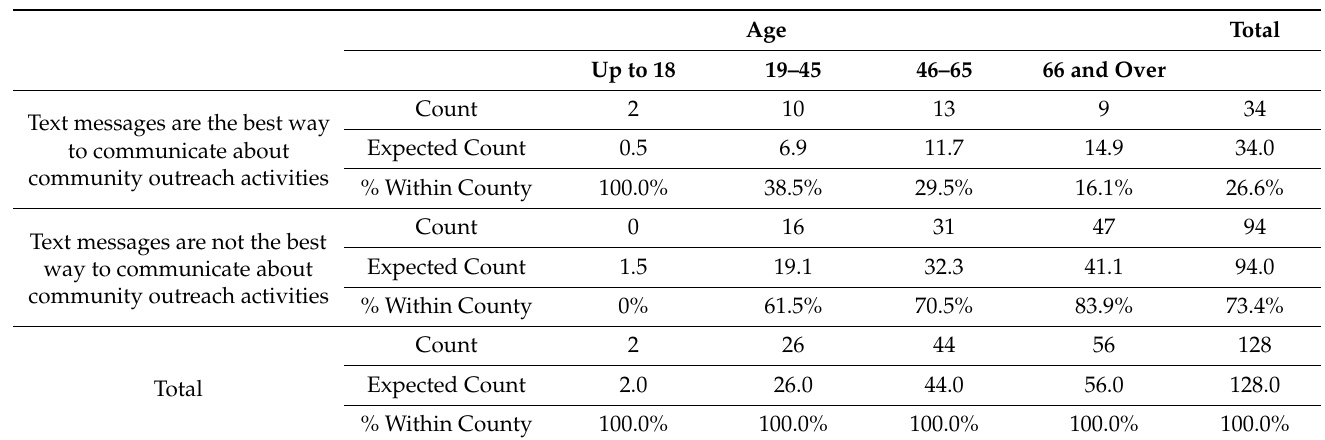
Table 16. Text Messages as the Best Way to Communicate with Respondents about Community Outreach Activities by